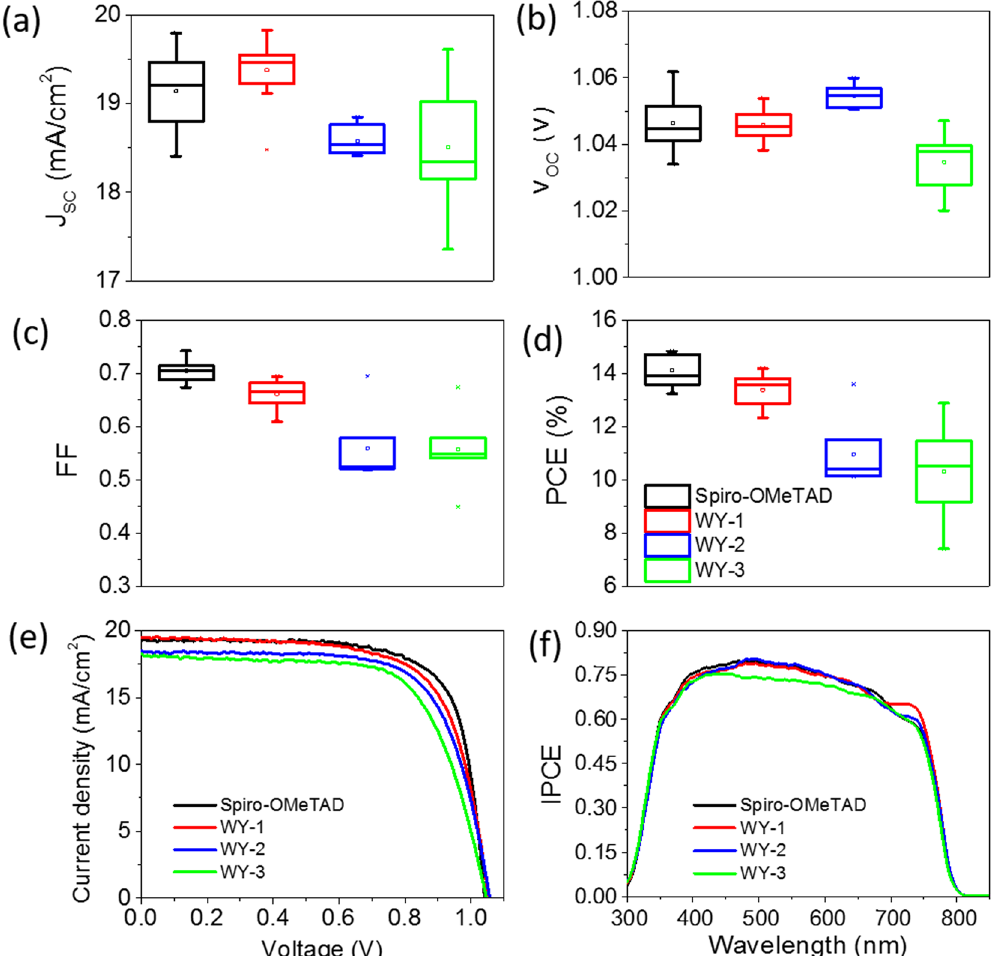
Figure 5. ( a – d ) Averaged J SC , V OC , FF and PCE of PSCs employed with different HTMs. ( e ) I-V curves of best-performing PSCs employing the studied HTMs, measured under AM 1.5 G illumination, 100 mW cm − 2 . ( f ) IPCE diagrams of the corresponding devices; the total currents derived from the integrated curves are: 18.05 mA/cm 2 , 18.16 mA/cm 2 , 18.08 mA/cm 2 and 17.32 mA/cm 2 for the spiro-OMeTAD, WY-1, WY-2, and WY-3-based device,